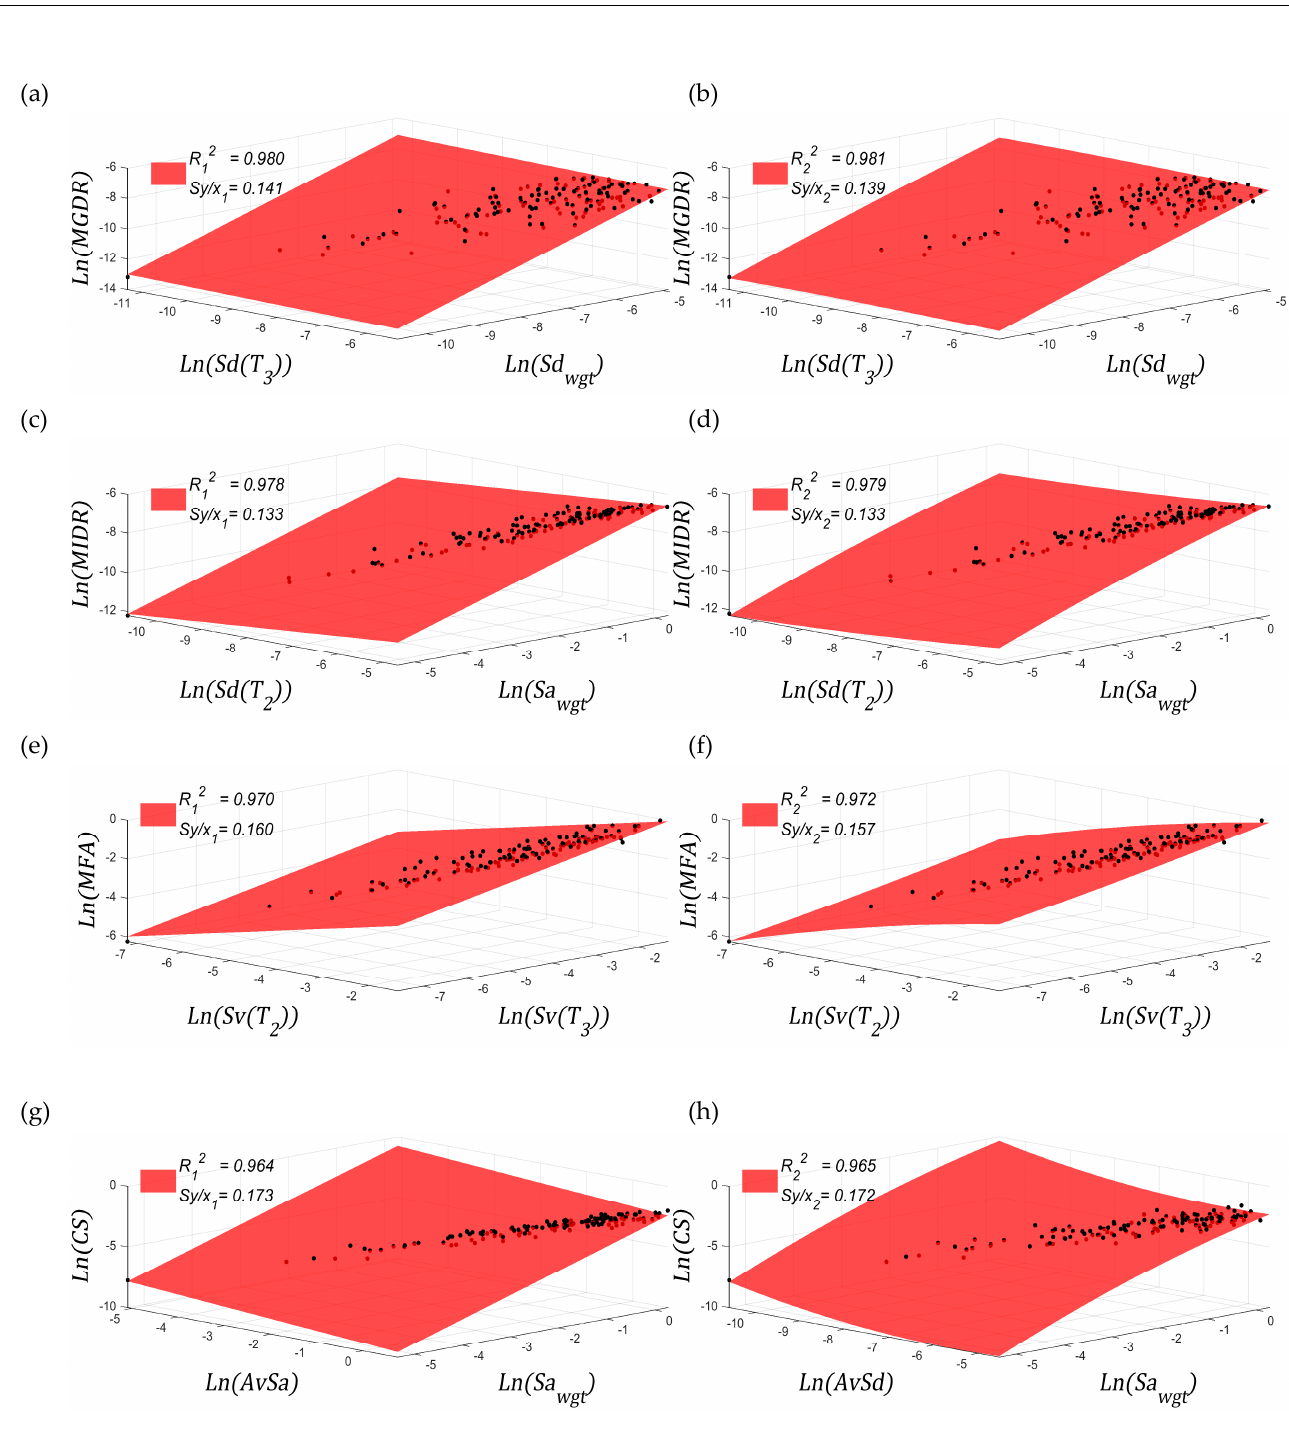
Figure 9. ( a – h )Statistical properties with elastic results; in these figures 𝑁 (cid:3010)(cid:3014) has been equal to